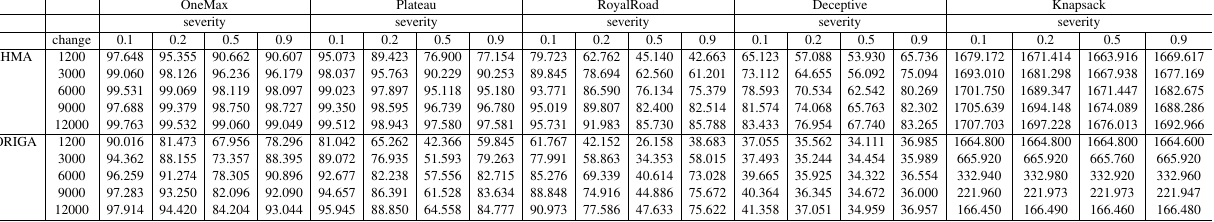
Table A.3. Offline performance obtained by AHMA and SORIGA for each problem, severity and frequency of change.